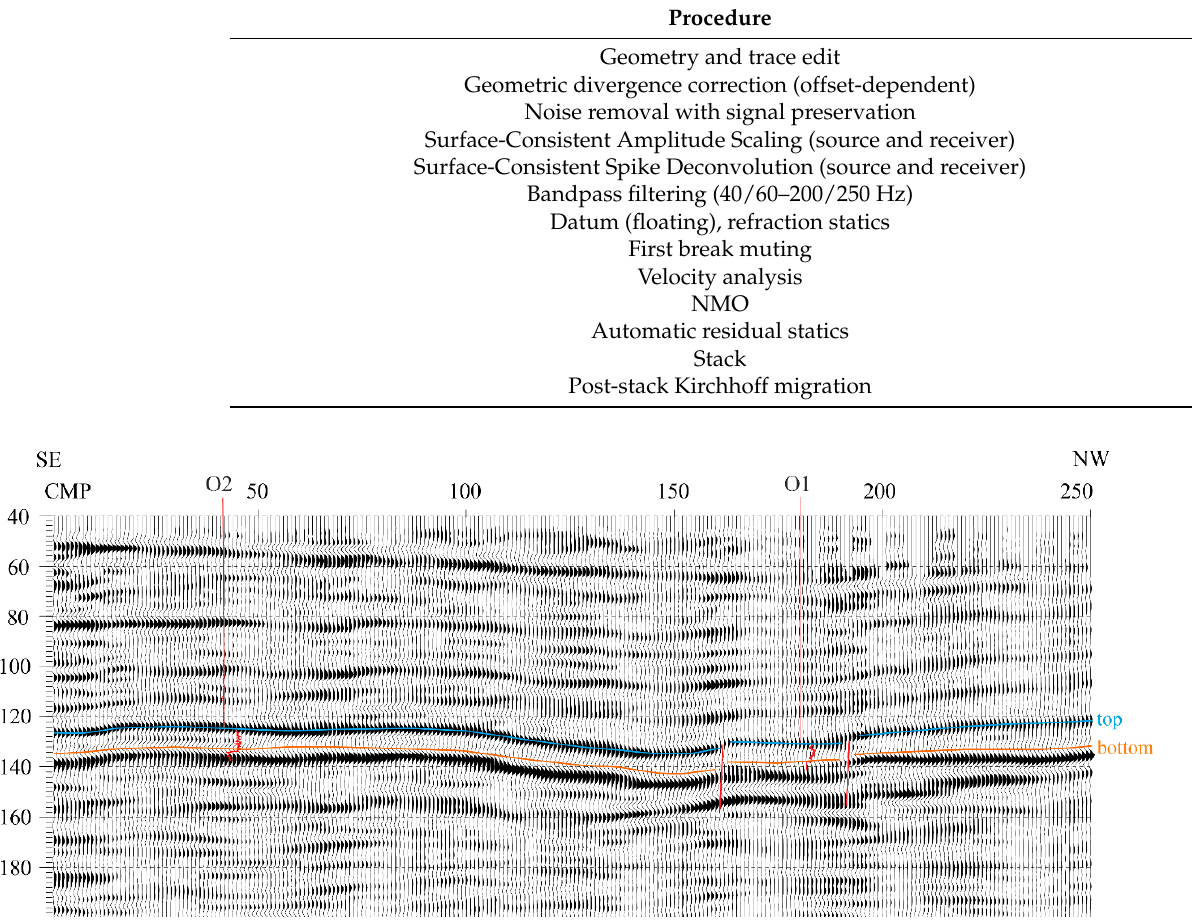
Table 2. Seismic data processing sequence.